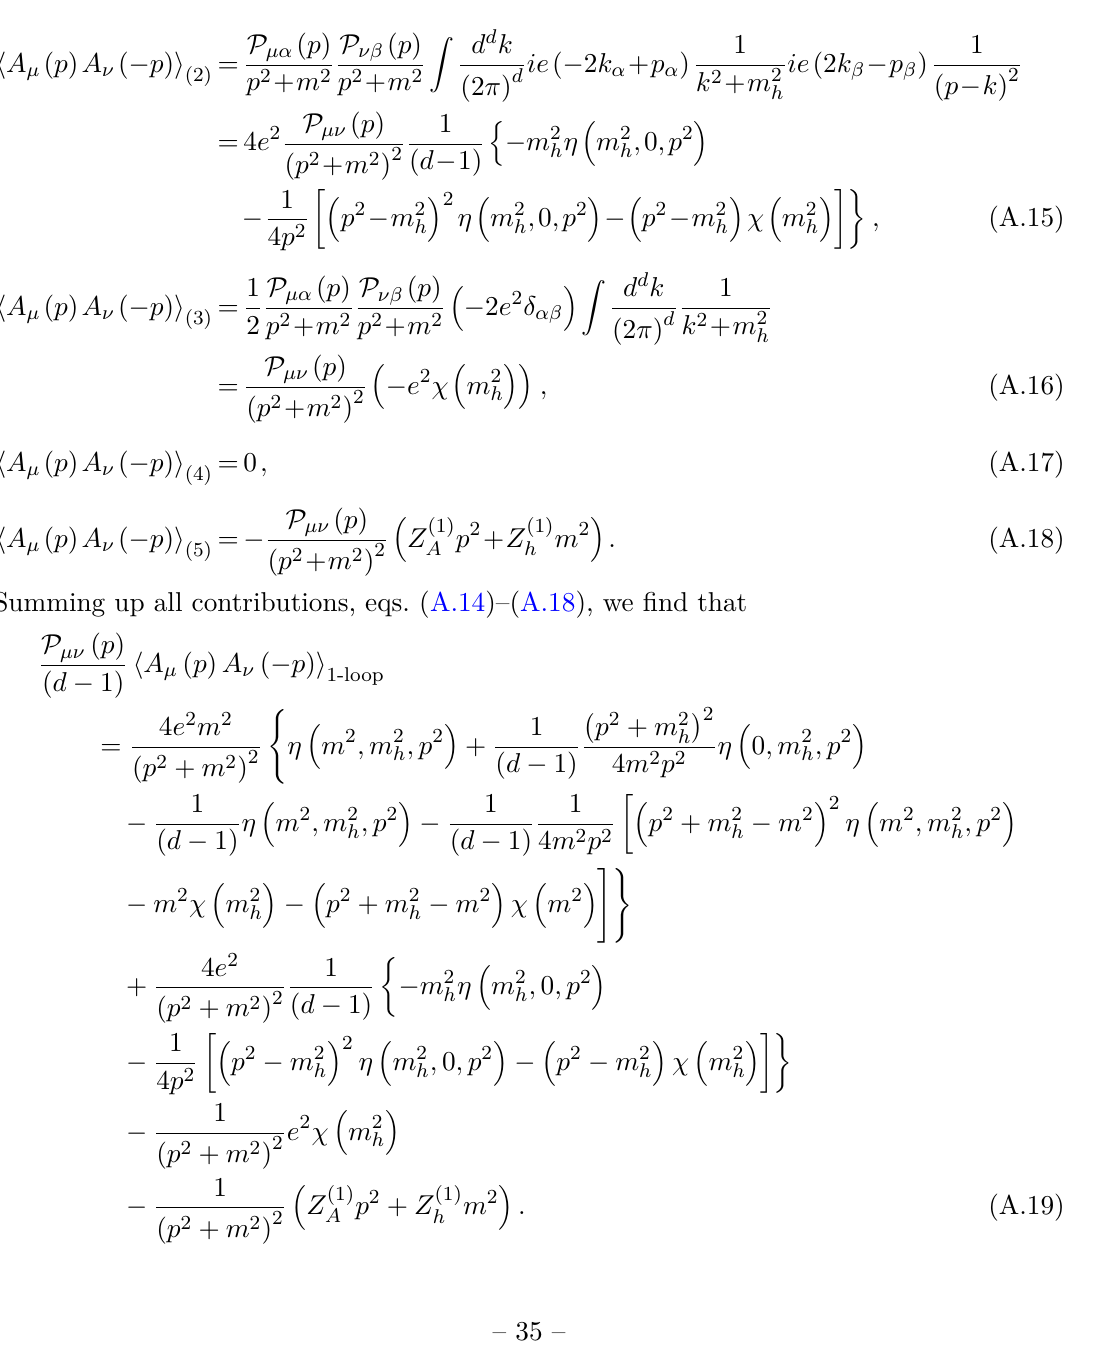
Figure 3 . Diagrams contributing to the one-loop two-point Green’s function of the Abelian gauge field A . Curly lines refer to the gauge field, solid ones to the Higgs field and dashed ones to the µ Goldstone